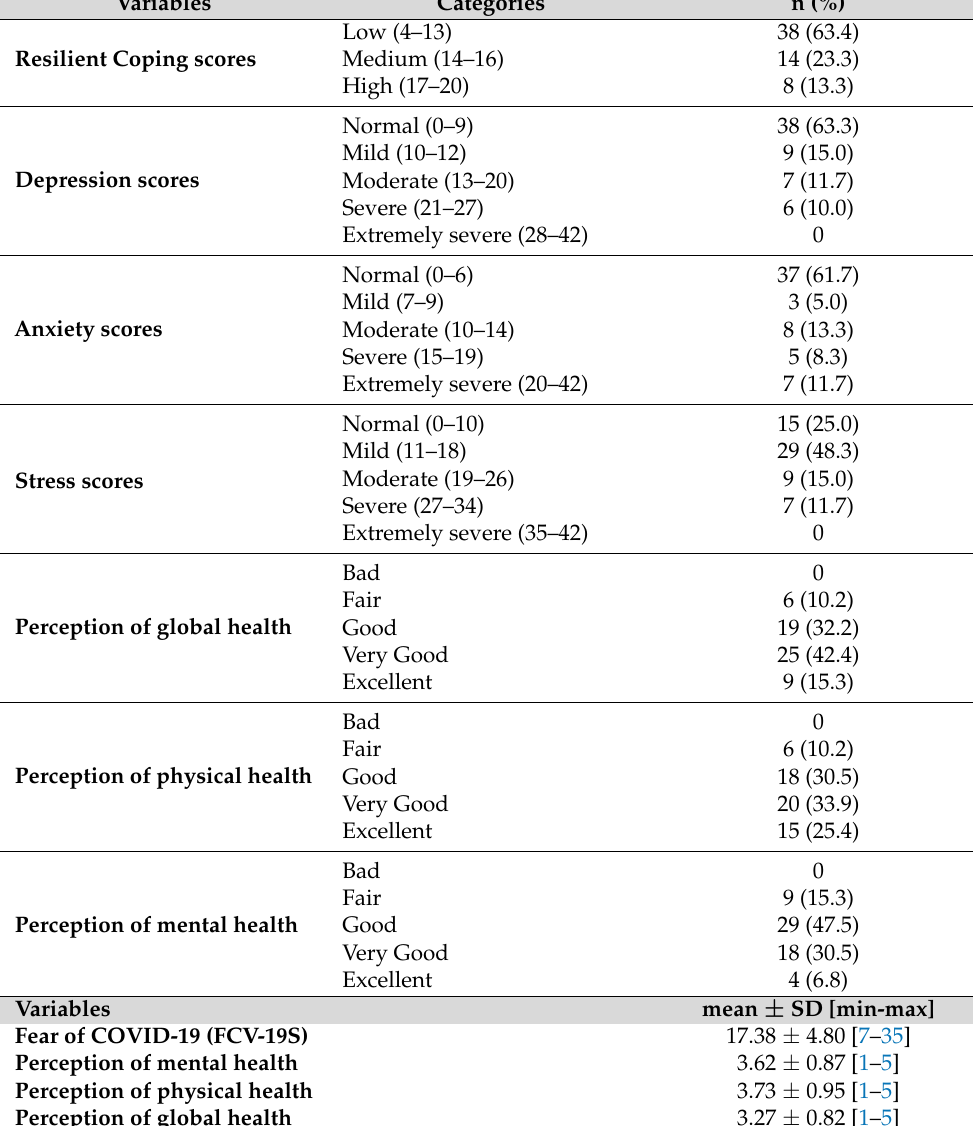
Table 2. Mental health status, fear, coping, and health-related perceptions of participants (n =